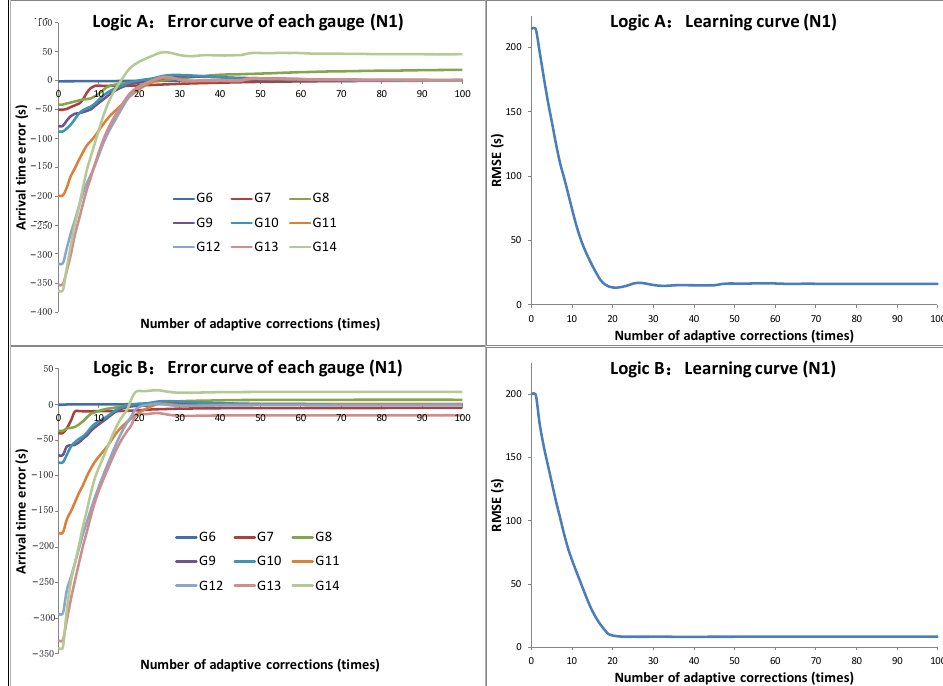
Figure 9. Error curve and learning curve of each gauge in logic A and logic B ( N 1 ).